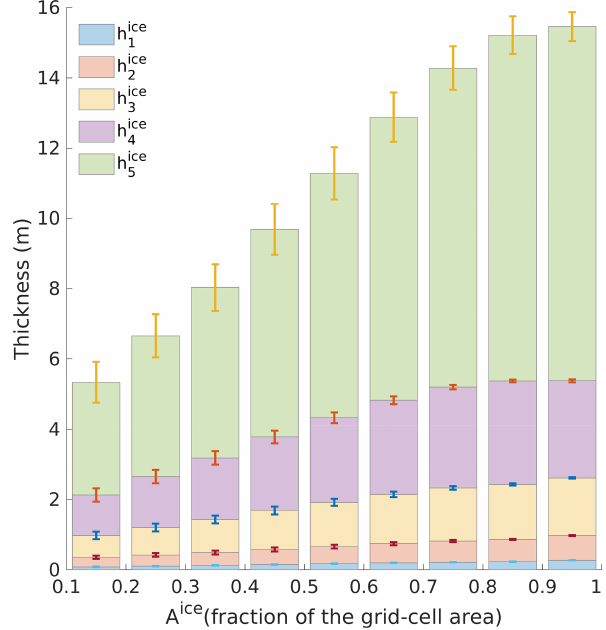
Figure 1. Multi-category ice thickness h ice ( l = 1 ,..., 5) distri- l bution on total ice concentration A ice [0.1–1] at intervals of 0.1 with mean (column) and standard deviation (error bar), based on the knowledge from a 300-year climate simulation with pre- industrial forcing. It is used to discretize h ice , if the total ice l concentration A ice and volume V ice at a grid cell (x,y) are known from anomaly initialization. For example, for all grid cells A ice falling in the bin 0.1–0.2, h ice ( l = 1 ,..., 5) is 0.08, l 0.27, 0.62, 1.15 and 3.20m, respectively. The ice volume at (x,y) = respective category ( l = 1 ,..., 4) is determined by v ice l g ice (x,y)h ice (x,y) is split from A ice (x,y) to each cat- , where g ice l l l egory by using a weight-likelihood function (see Eqs. 1–3). For the (x,y)/g ice (x,y) , where fifth category, h ice is determined by v ice 5 5 5 v ice (x,y) = V ice (x,y) − (cid:80) 4 g ice (x,y)h ice in Eq. (5). Note that l = 1 l l 5 the grid-box mean thickness H ice (x,y) = V ice (x,y)/A ice (x,y) = (cid:80) 5 h ice g ice (x,y) (cid:54)= (cid:80) 5 v ice (x,y)/ (cid:80) 5 . Therefore, H ice is l = 1 l = 1 l = 1 l l l regulated by both V ice and g ice at the local l